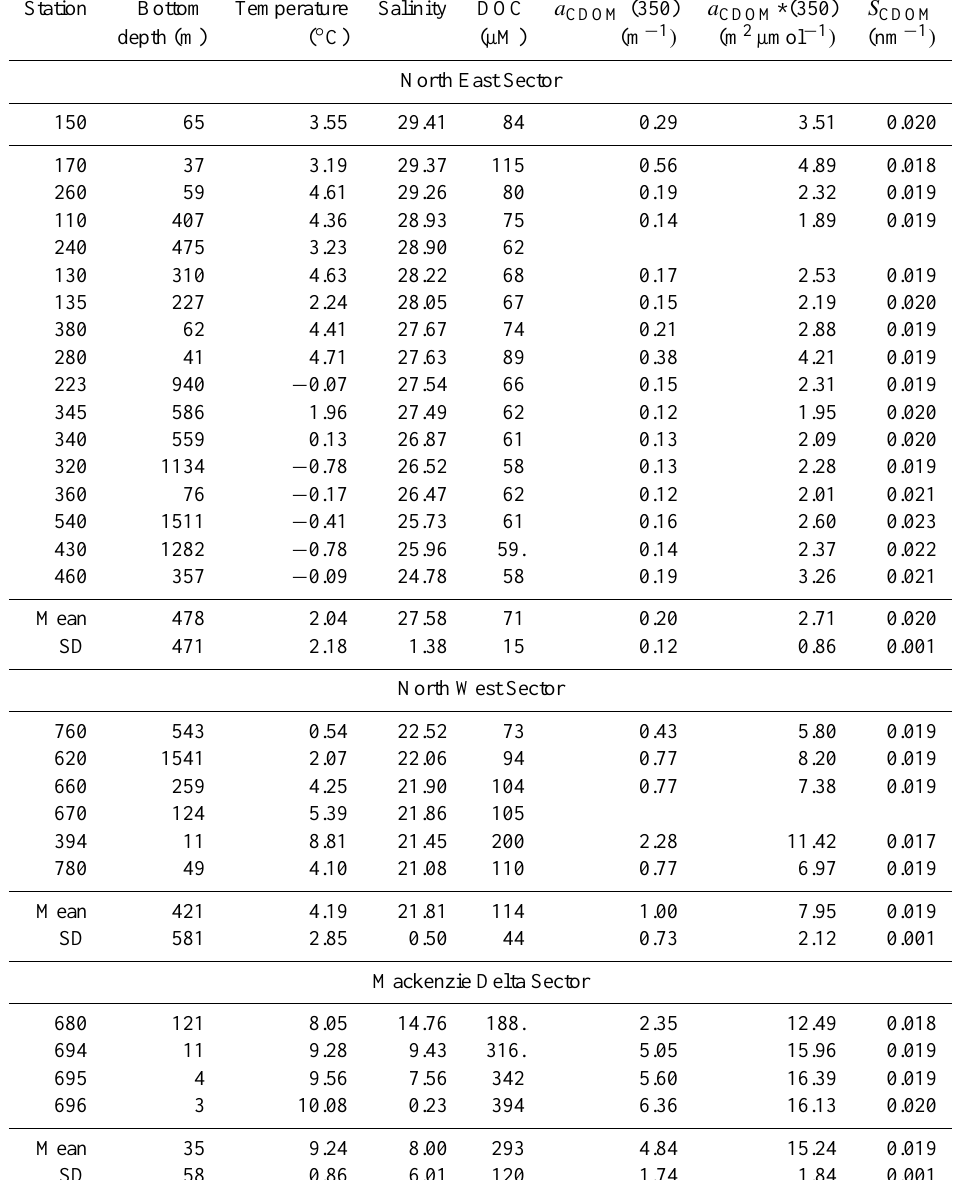
Table 1. Bottom depth, temperature, salinity, DOC and absorbance properties, including CDOM absorption coefficient, specific absorption coefficient at 350nm ( a CDOM *(350)) and the spectral slope determined in surface waters of each sampling station and among the different sectors investigated (i.e. North East, North West and Mackenzie Delta sectors)